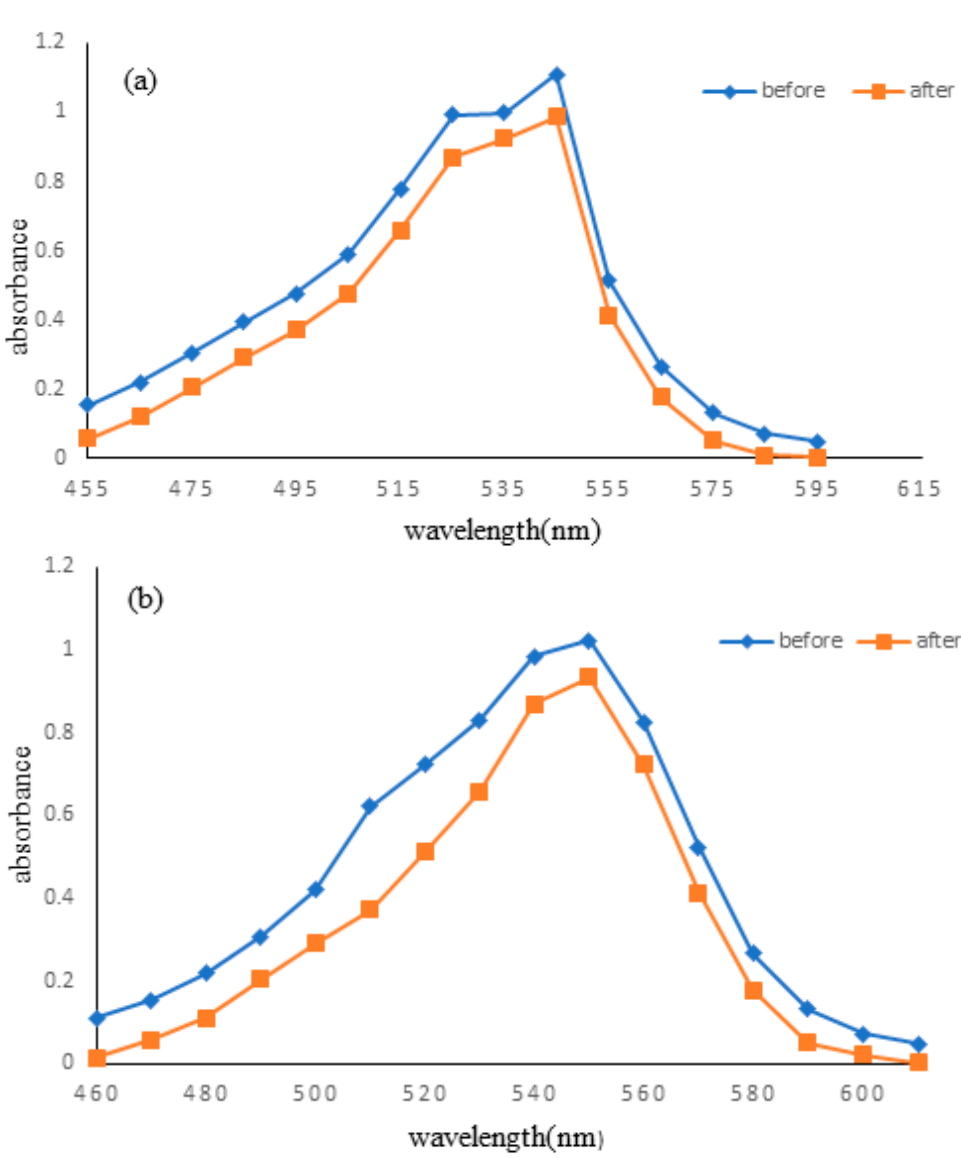
Figure 5. Maximum wavelengths of ( a ) Reactive Violet and ( b ) Direct Violet.